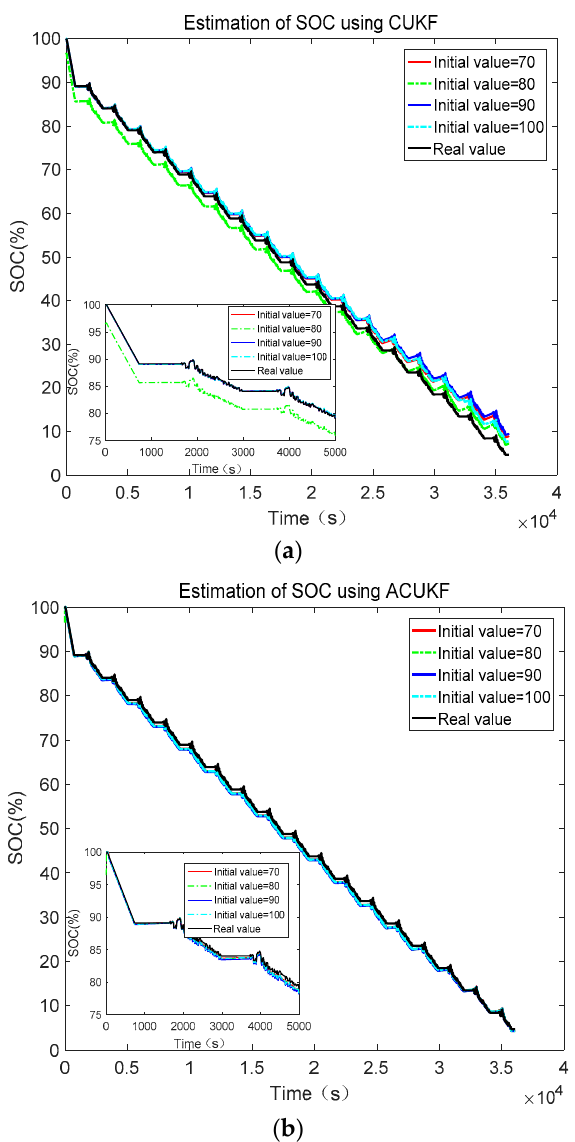
Figure 11. SOC estimation results for correntropy unscented Kalman filter (CUKF) vs. adaptive correntropy unscented KF (ACUKF) with different SOC initialization. ( a ) SOC estimate results of CUKF; ( b ) SOC estimate results of ACUKF.